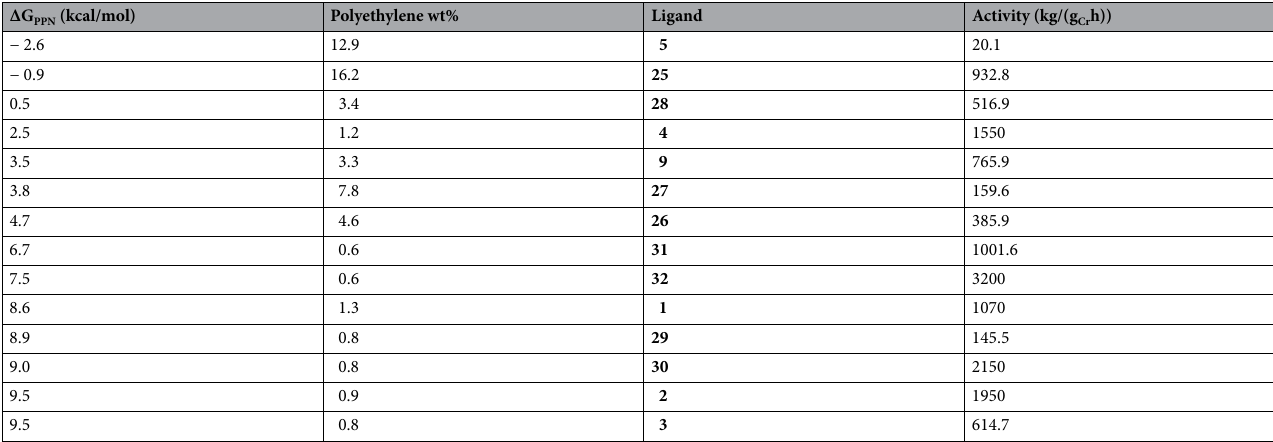
Table 3. Reported polyethylene production (wt.%) versus ΔG PPN (kcal/mol). a Catalytic data were obtained under similar conditions from three papers from Sasol researchers: 1 , 2 , 4, 5 , 30 , 32 from ref. 46 ; 3 from ref. 44 ; and 9 , 25 – 29 , and 31 from ref. 51 : 300 mL Parr reactor using 100 mL methylcyclohexane at 60 ˚C, 45–50